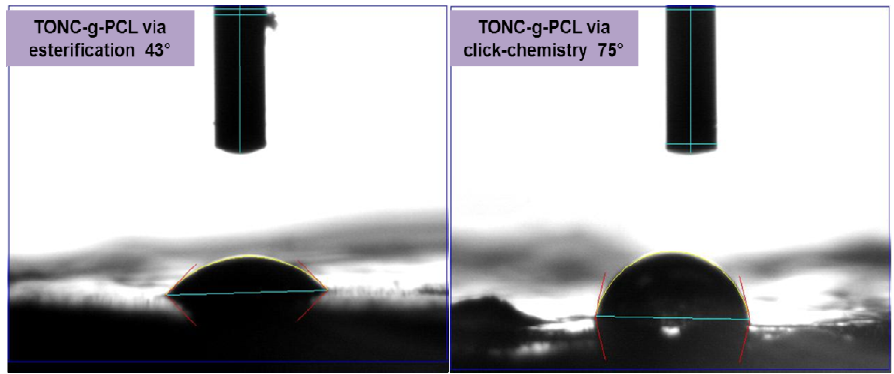
Figure 11. Profiles of water contact angles on TONC-g-PCL via esterification and TONC-g-PCL via click-chemistry 25 s after drop